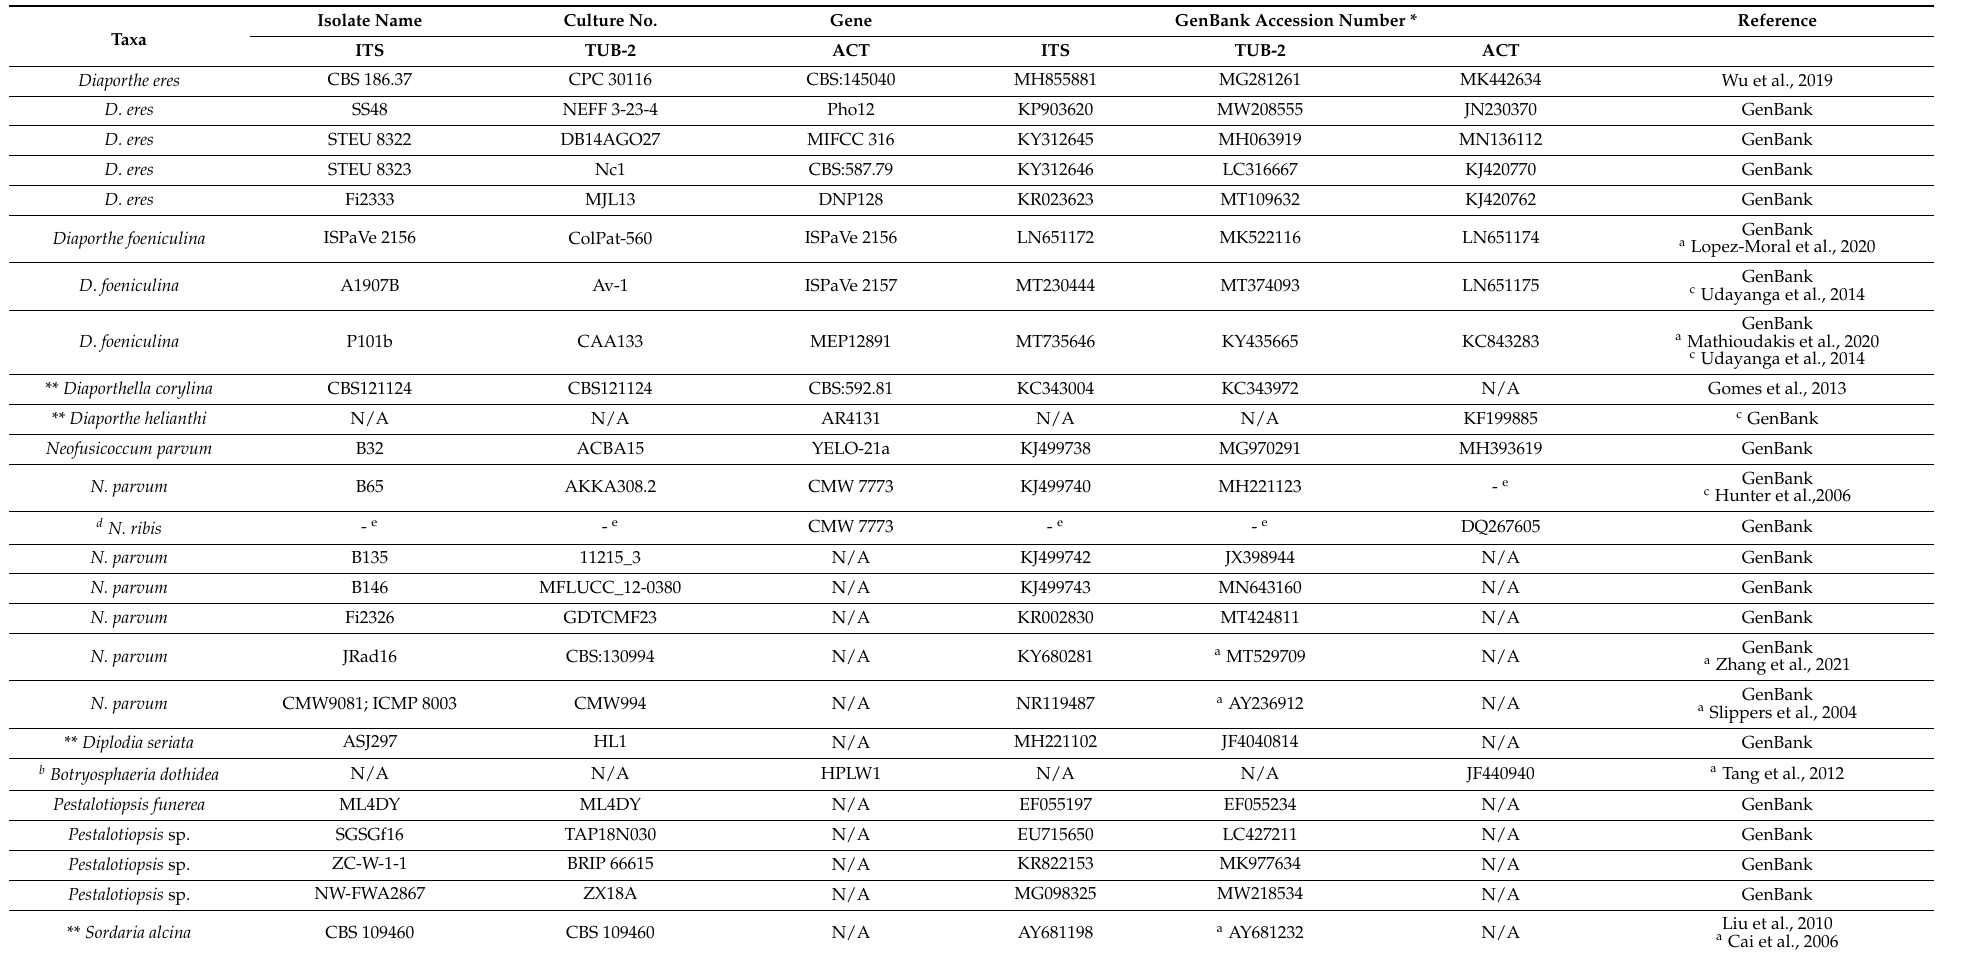
Table 3. List of taxa, fungal isolates and GenBank accession numbers of the genes analyzed in this study and used for phylogenetic